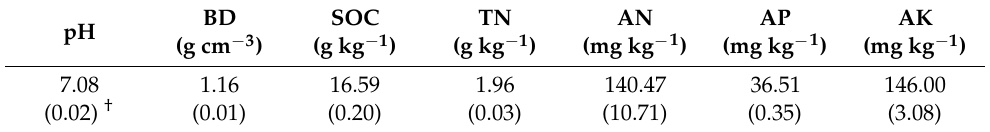
Table 1. Basic soil properties in the 0–20 cm soil layer at the start of the